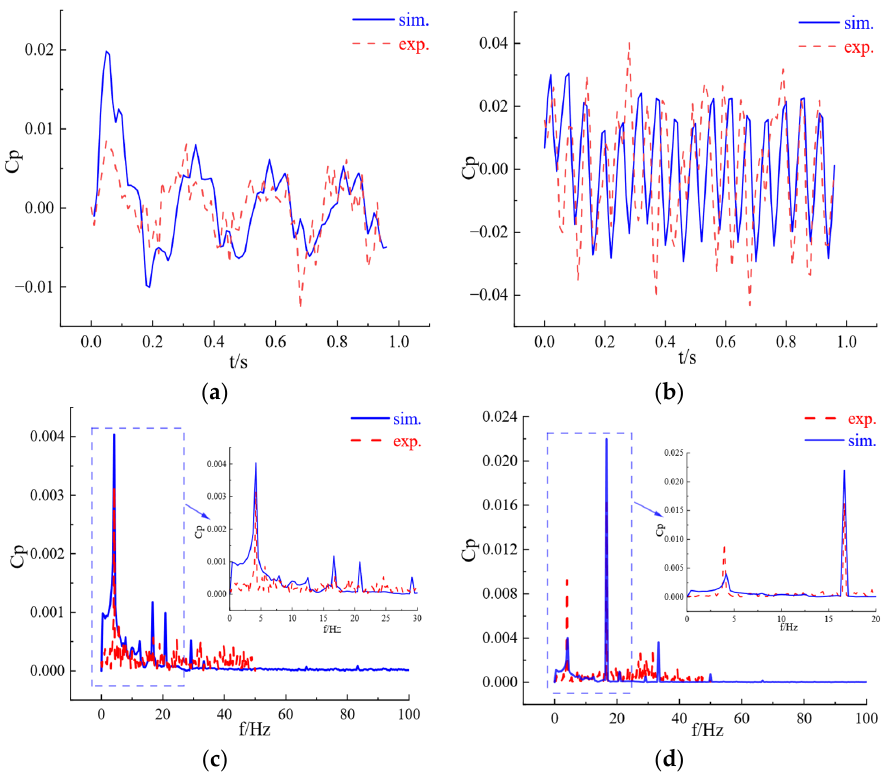
Figure 8. Comparison of experimental and numerical simulation results. ( a ) Time domain diagram of inlet pressure pulsation of preguide vanes. ( b ) Time domain diagram of runner inlet pressure pulsation. ( c ) The frequency domain diagram of the inlet pressure pulsation of the front guide vane. ( d ) Frequency domain diagram of runner inlet pressure pulsation.